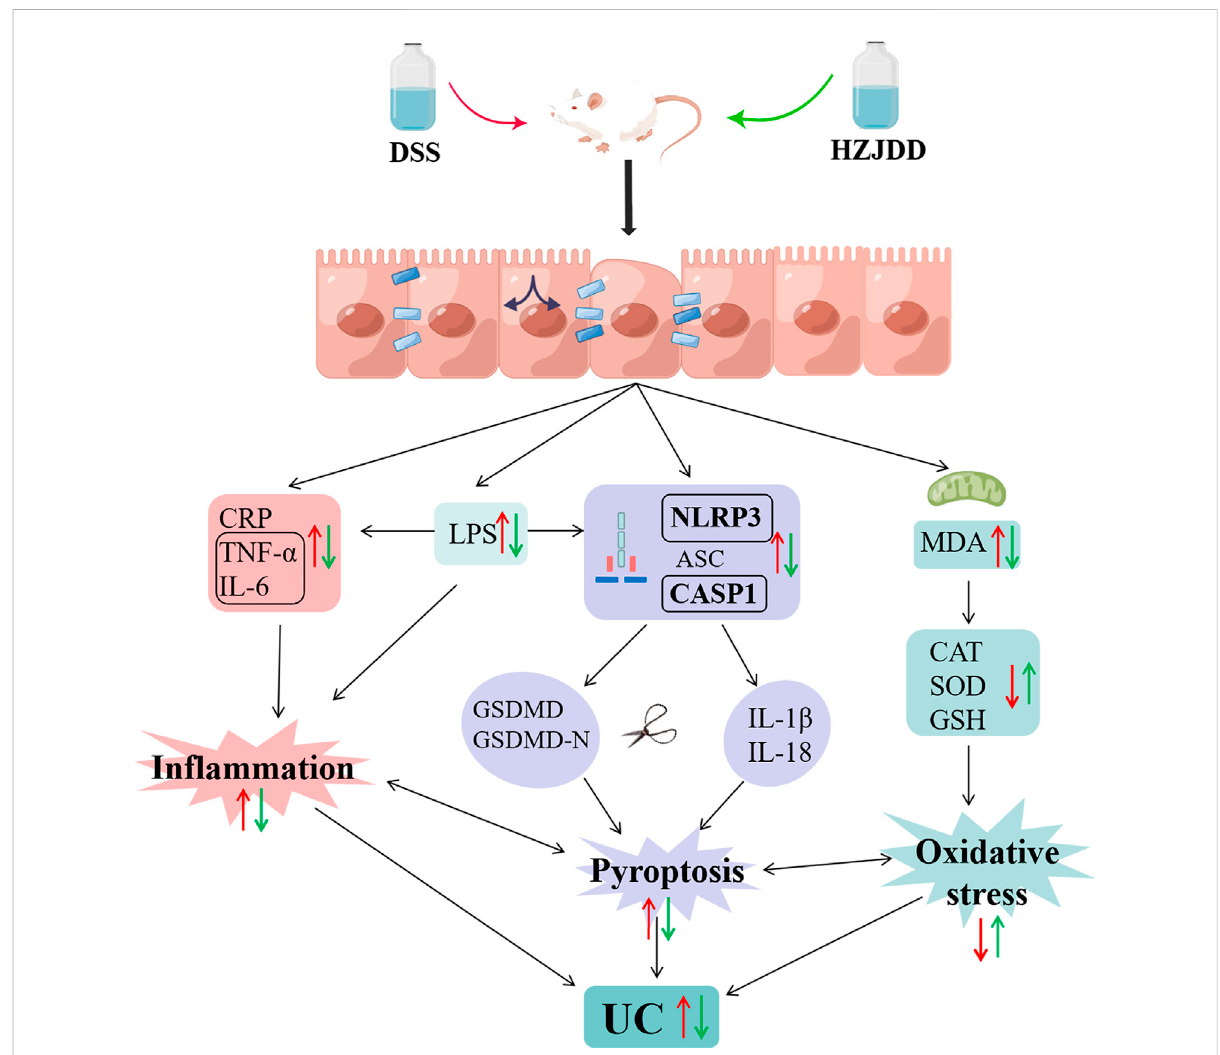
FIGURE 10 The protective mechanism of HZJDD against DSS-induced UC (this image was created using